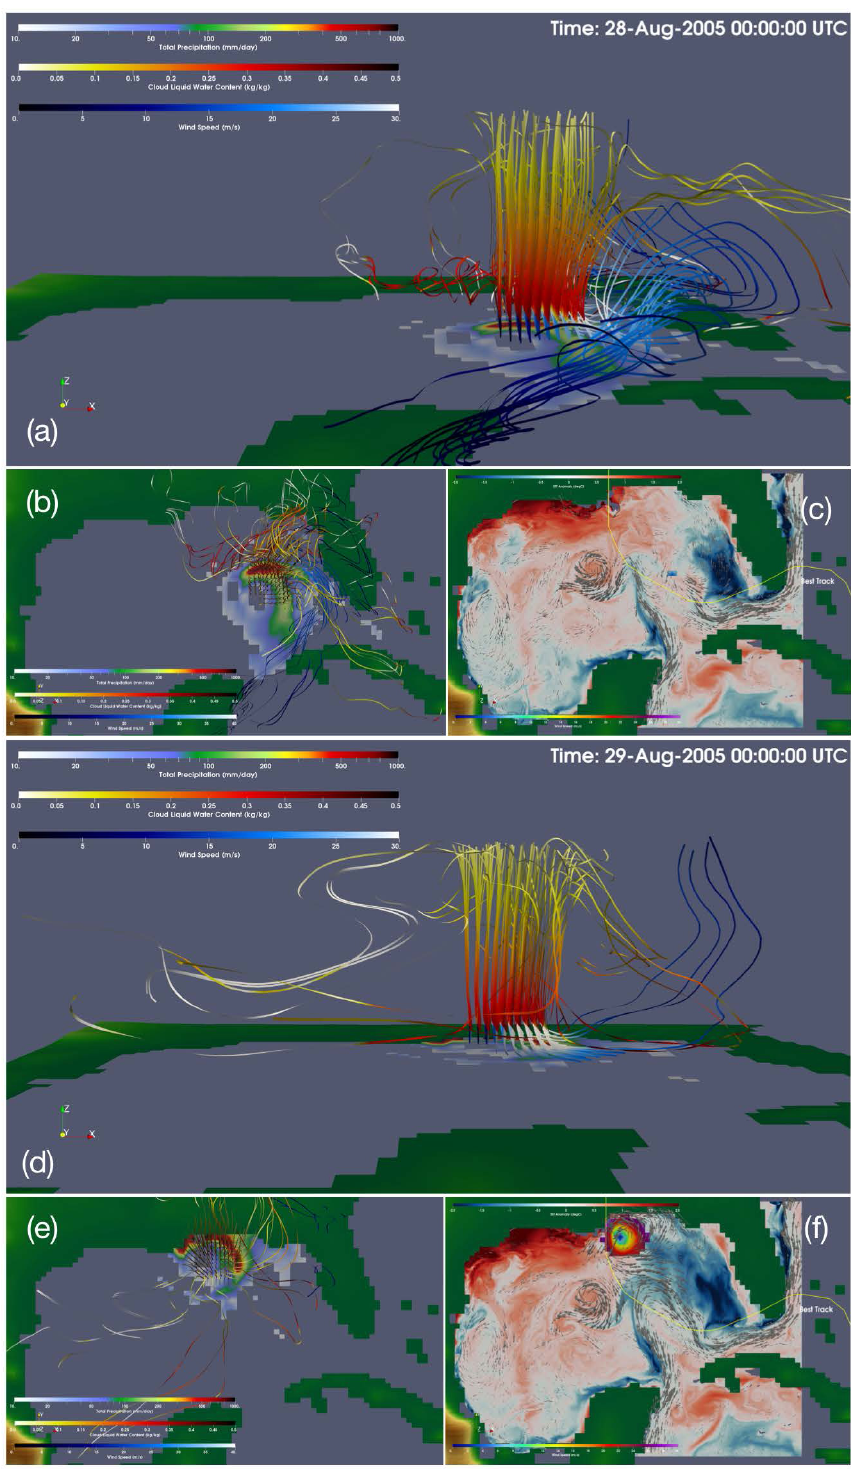
Figure 13. Rendering of three-dimensional vorticity streamlines (s − 1 ), total precipitation (mmday − 1 ) and sea surface temperature anomaly ( ◦ C) of the COP_LR simulation for 28 August 2005, 00:00UTC (a–c) and 29 August 2005, 00:00UTC (d–f) . Streamlines are calculated only from the eye of the hurricane. In this case, red- and yellow-colored forward streamlines represent cloud liquid water content (kgkg − 1 ), and blue-colored backward streamlines indicate wind speed (ms − 1 ). The solid yellow line represents the best track of Hurricane Katrina, which is extracted from the HURDAT2 database. The larger versions of figures are also given in the